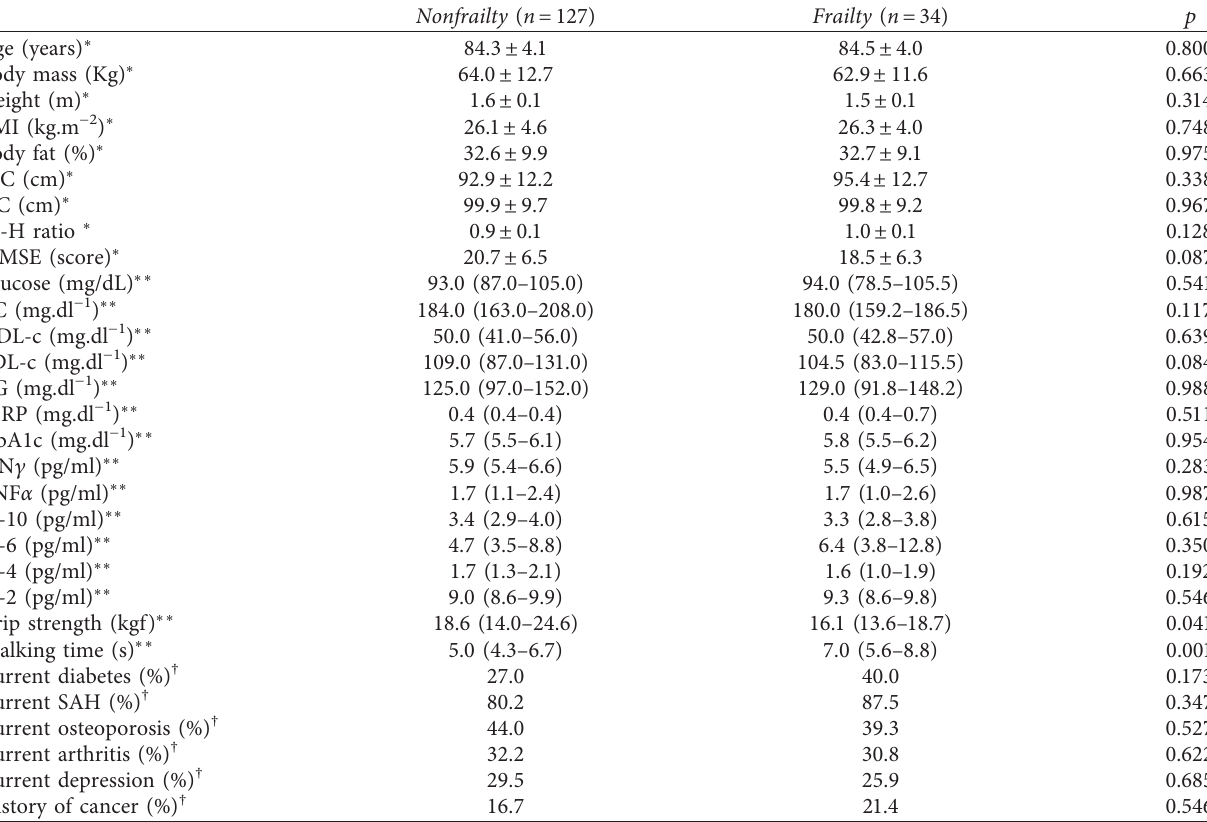
Table 1: Anthropometric and metabolic characteristics of the sample according to clinical condition.